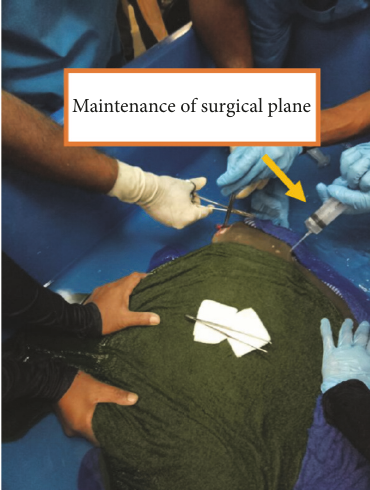
Figure 6: Diluted gentamycin was used to flush the orbital space and globe to reduce contamination.